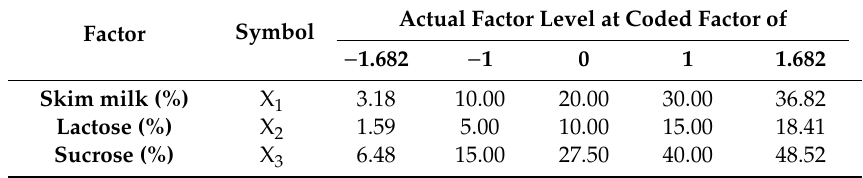
Table 6. Actual factor levels corresponding to coded factor levels for three